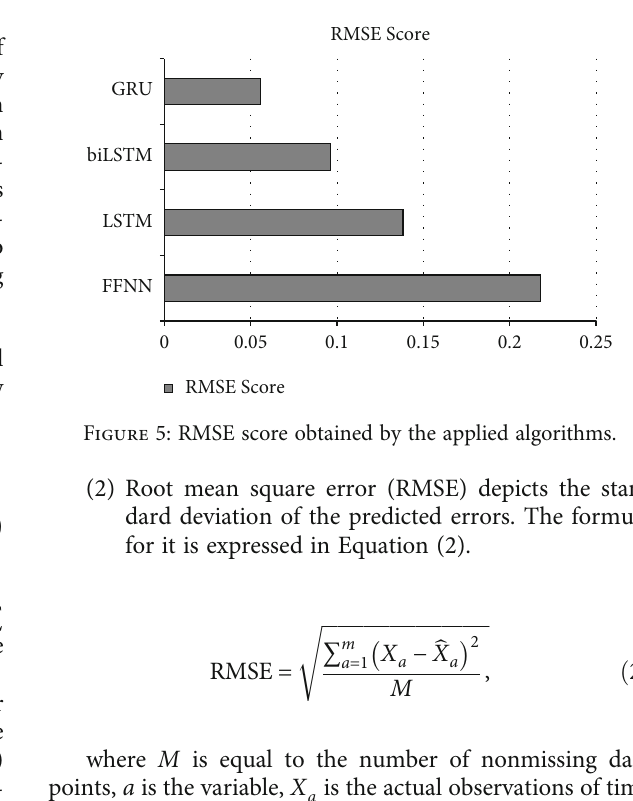
Figure 4: MAE values obtained by the proposed and other models.